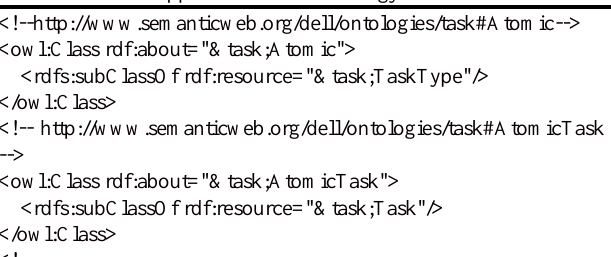
Table 1. Snippets of the task ontology file in